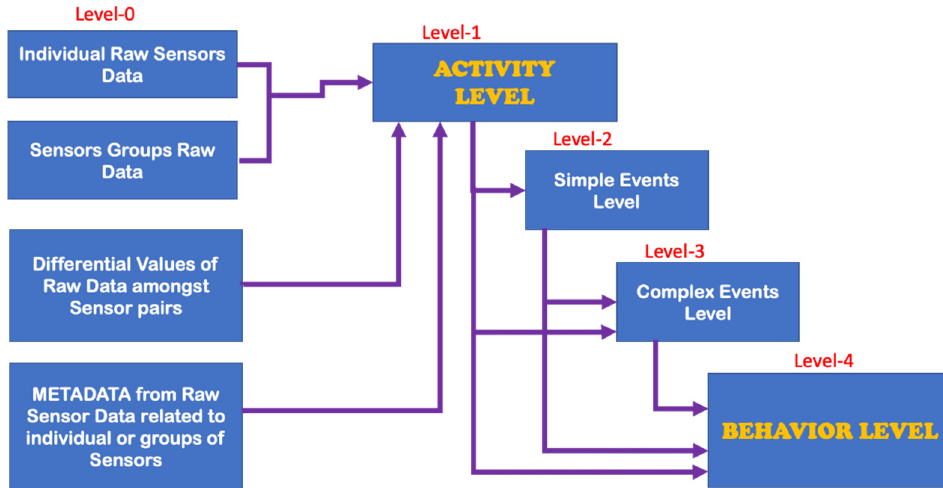
Figure 3. Presentation of the four major data-processing levels that were used in the comprehensive ontological framework for defining the general “anomaly” concept.